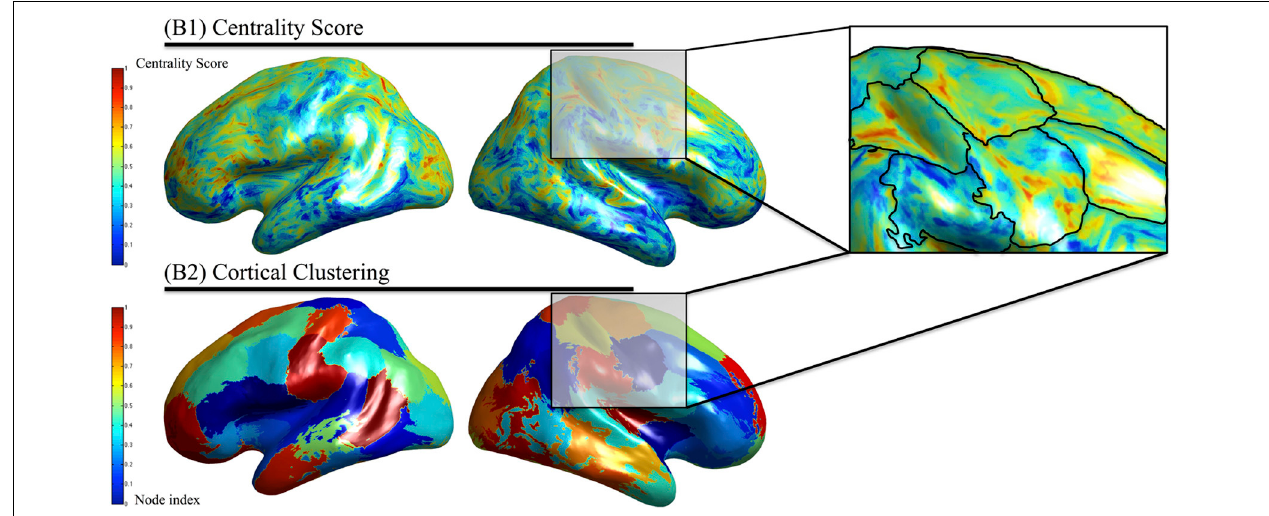
FIGURE 4 | Identification of functionally defined regions in subject data. The eigenvector centrality at each cortical location averaged across multiple subjects (above) is used as input to the clustering algorithm that